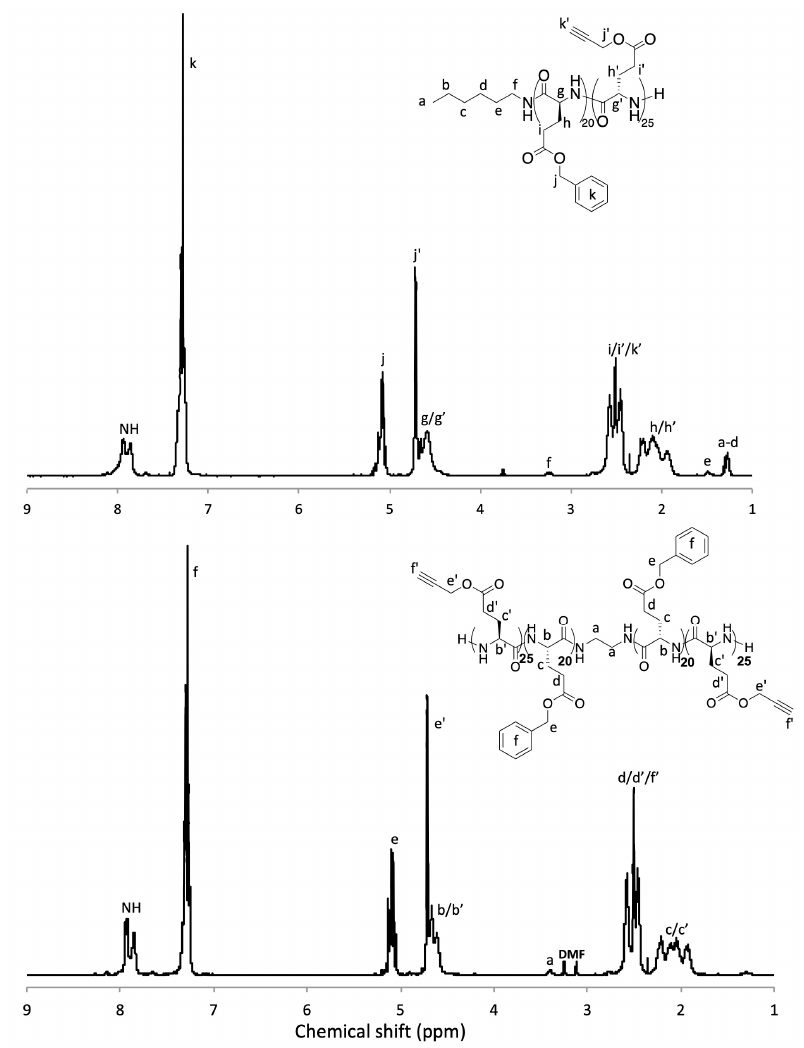
Figure 2. 1 H NMR analyses of the PBLG- b -PPLG diblock (top) and PPLG- b -PBLG- b -PPLG triblock (down) copolypeptides (solvent: CDCl 3 + 15% TFA). Table 1. Characteristics of the polypeptides obtained upon ROP (see Figure S2).